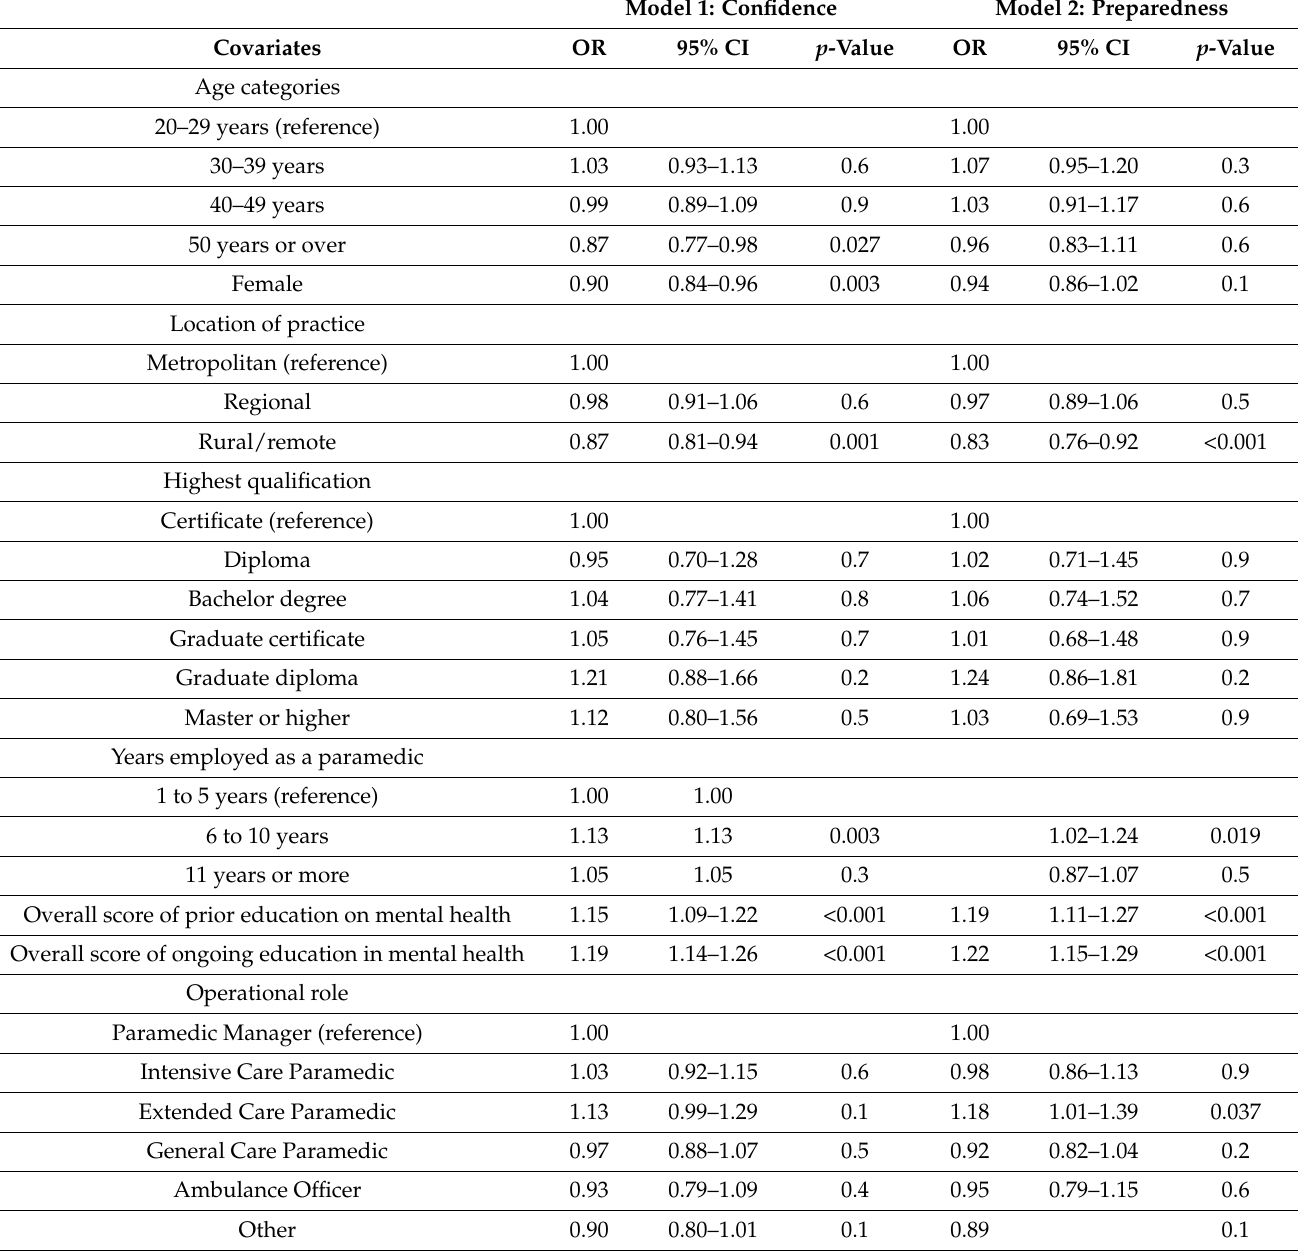
Table 3. Factors predicting confidence and preparedness of paramedics to manage mental health states: multivariable